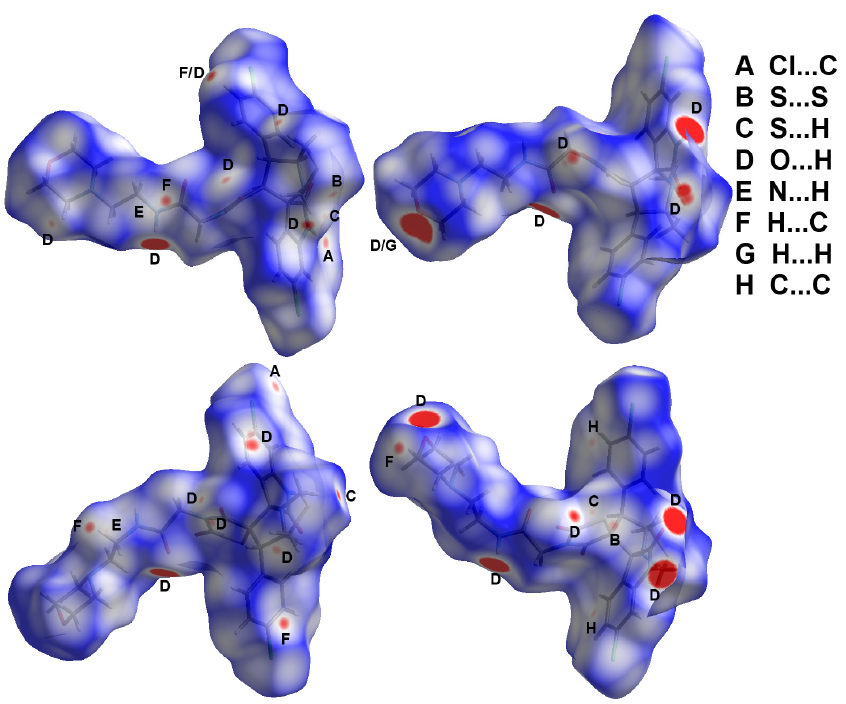
Figure 3. The d norm maps of the two molecular units (top: unit A; bottom: unit B) showing the most important contacts in 5a .